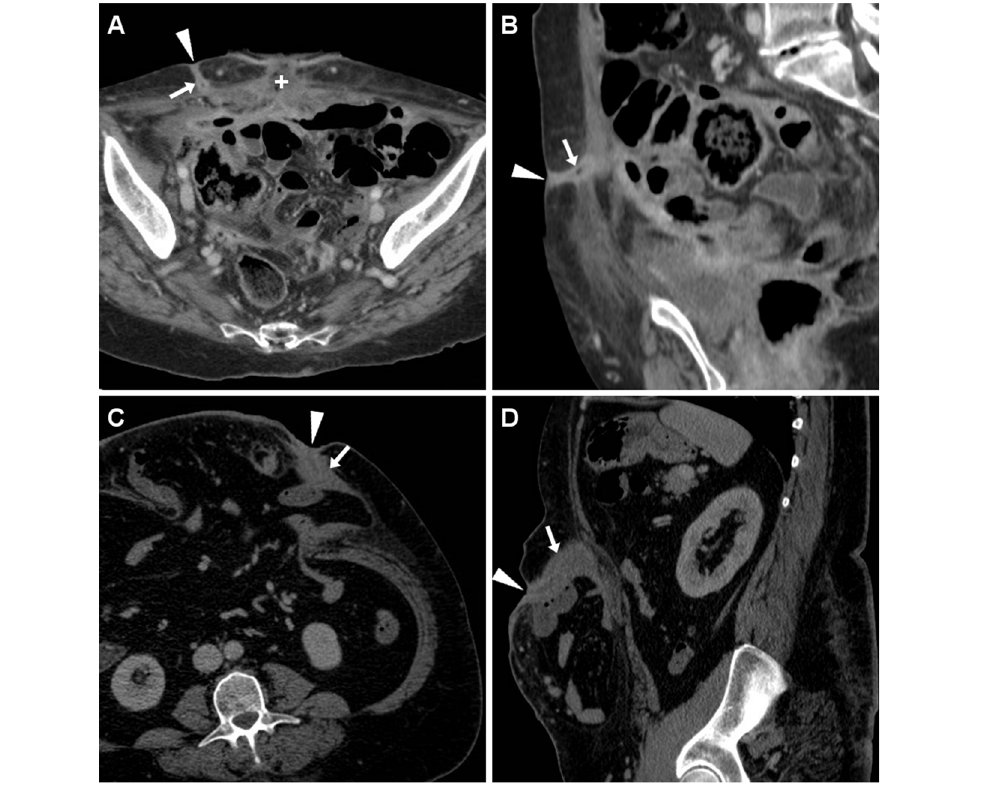
Fig. 3 Early postoperative ECF ina 74-year-old woman following cytoreductive surgery for ad- vanced endometrial carcinoma with peritoneal carcinomatosis. Characteristic CT ( A , B ) findings included enhancing B tram-track ^ paired structures (arrows) cross- ing from the peritoneal cavity through the anterior abdominal wall to the EFO (arrowheads), separated from the recent laparotomic access site (+). The ECF ultimately healed with prolonged in-hospital conserva- tive treatment Another ECF developing in a 54- year-old obese woman with post- incisional abdominal evisceration: corresponding CT ( C , D ) appear- ance included thick-walled enhanc- ing fistula (arrows) coursing from a herniated small bowel loop to the focallyretractedEFO (arrowheads). Surgical treatment included ECF